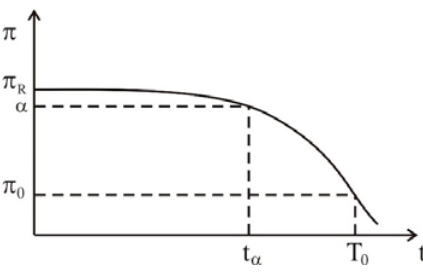
Fig. 11. Deterioration of functional capabilities Fig. 12. Variation of the reliability deterioration coefficient